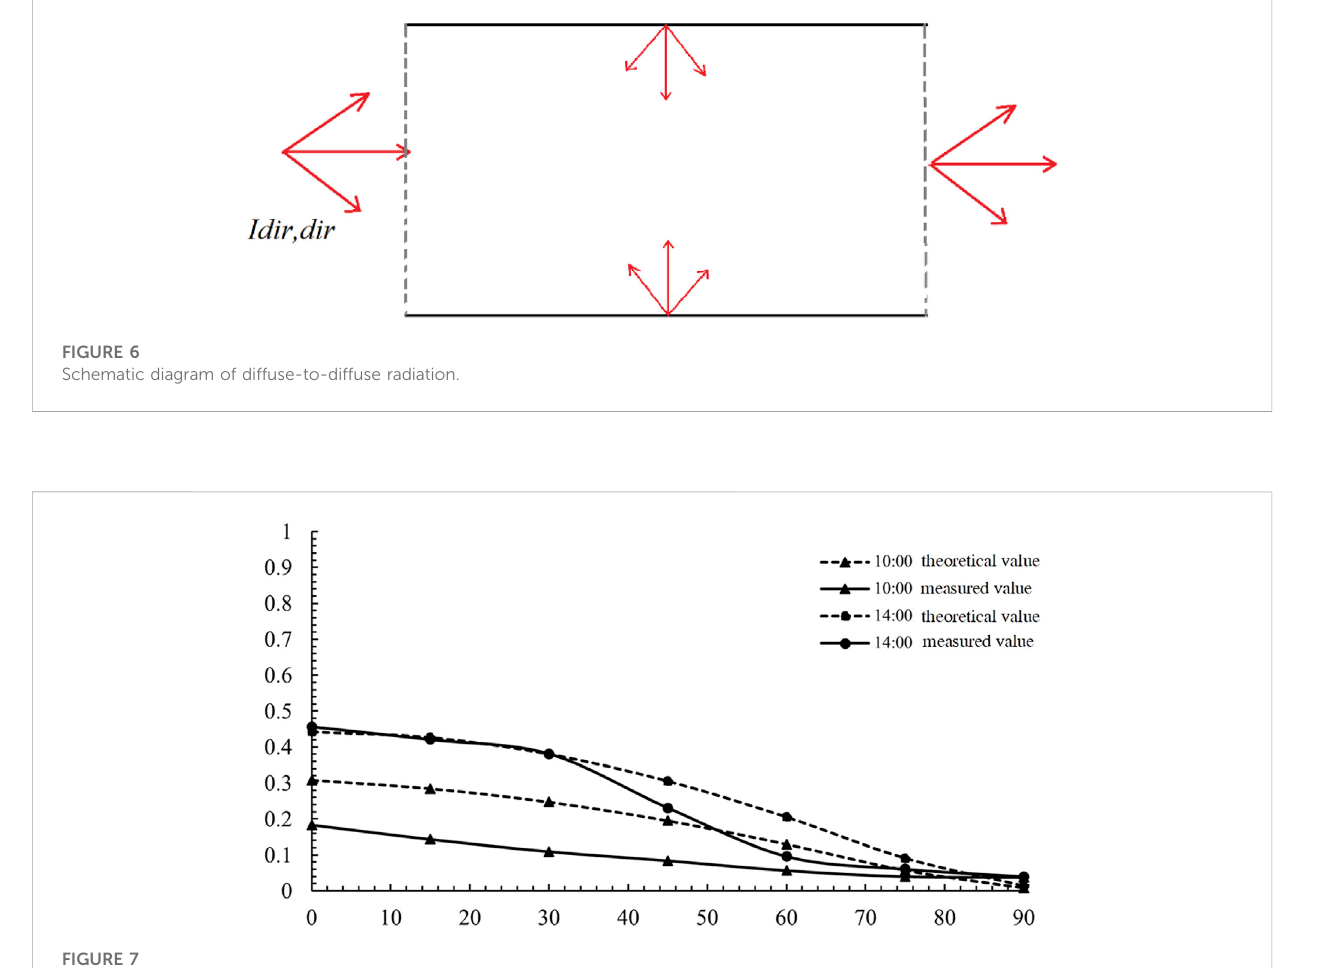
Frontiers in Built